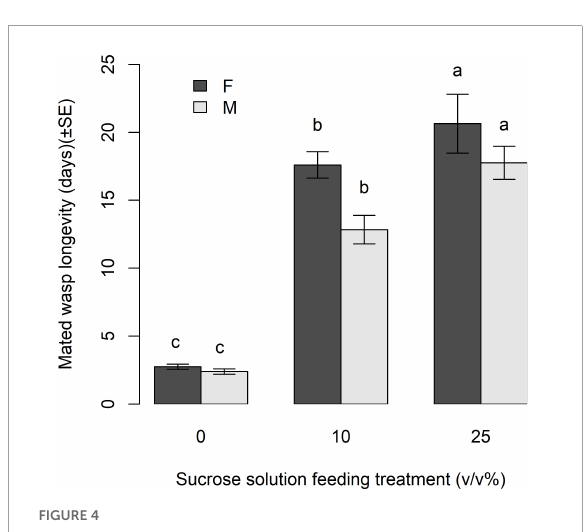
FIGURE4 Mean longevity (d) of mated Apanteles polychrosidis . Each wasp ( n = 30–42 per treatment) was provided with a feeding treatment of either 10 or 25% (v/v) sucrose in deionized water, or a deionized water control (0). Bars marked with different letters are significantly different ( p < 0.05) [compact letter display (cld) of multiple pairwise comparisons].